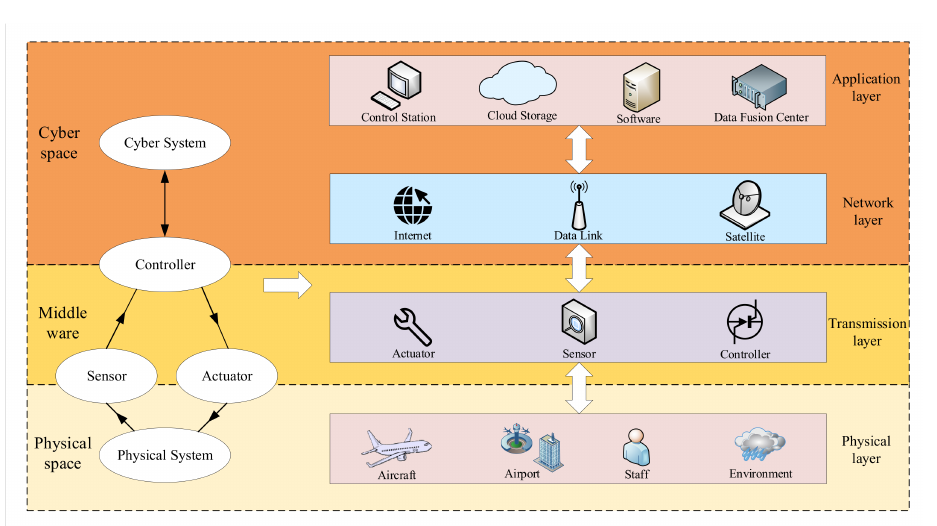
Figure 2. Layered Architecture of the